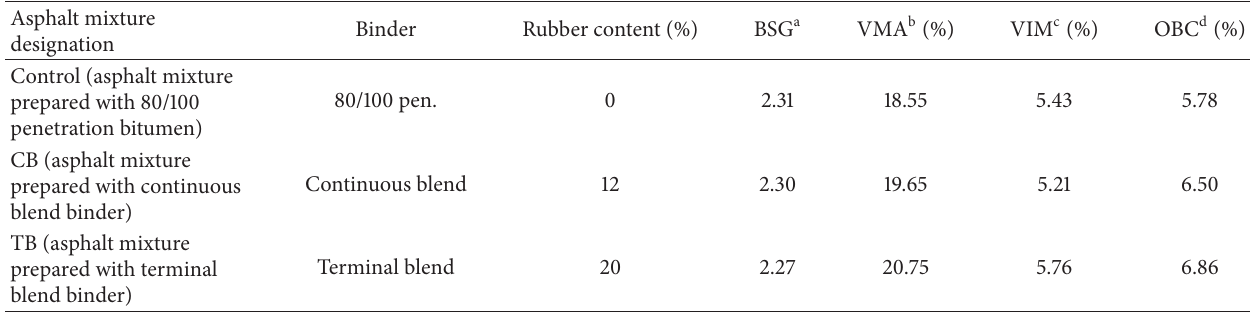
Table 6: Summary of asphalt mixture.